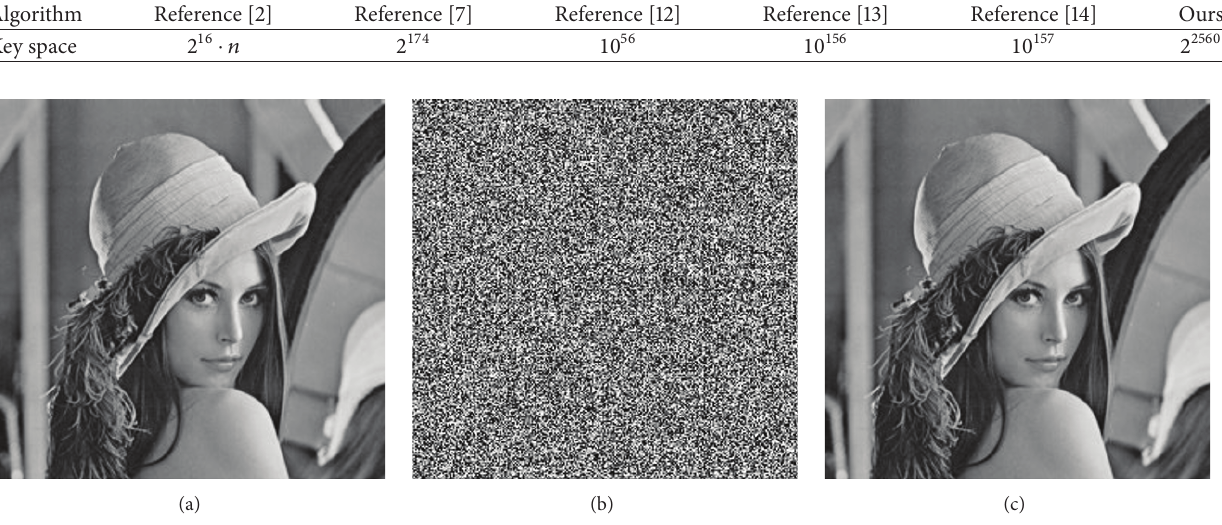
Figure 5: Experimental results for the image.